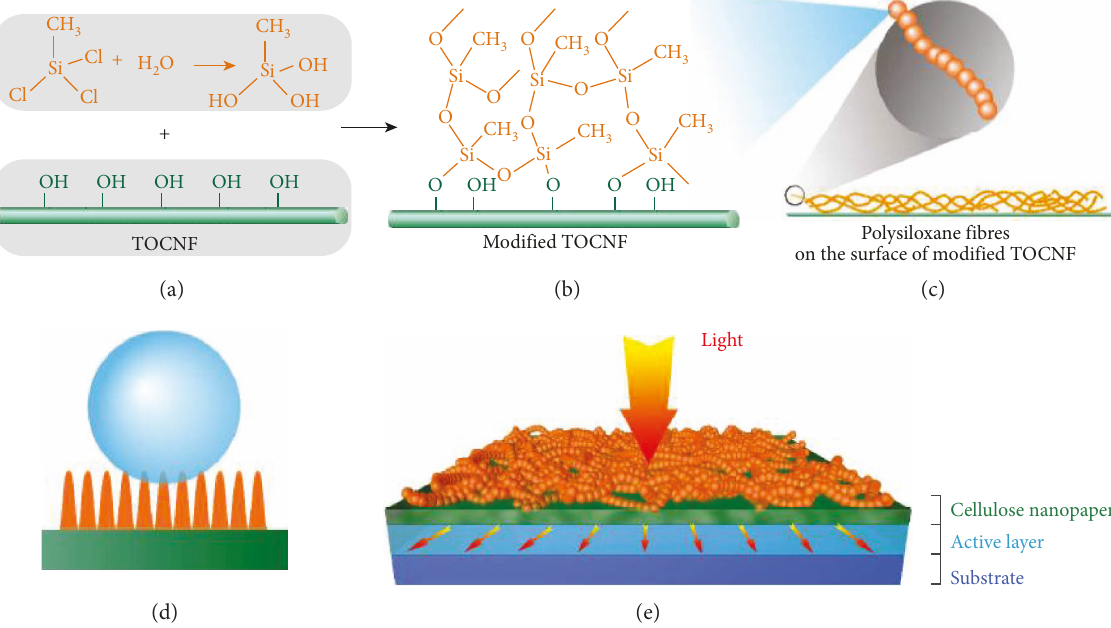
Figure 11: Tempo-oxidized cellulose nano fi bril paper modi fi ed with polysiloxanes (a – c). The polysiloxane fi bres transform the nanopaper into a superhydrophobic surface (d). The cellulose nanopaper is transparent and presents high haze and was used to optimize the performance of a solar cell (e). Reproduced from reference [47] with permission from the American Chemical